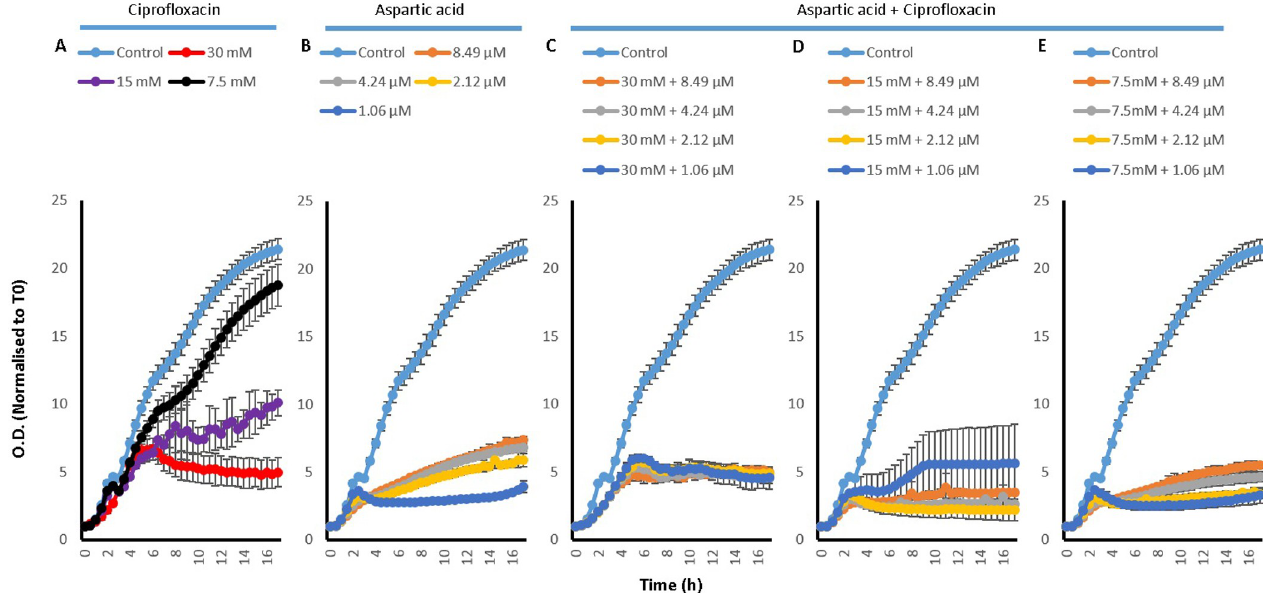
Fig 3. S . aureus growth curves with A) 30, 15 and 7.5 mM L-Asp amino acid on its own, B) with 8.49, 4.24, 2.12 and 1.06 μ M Cip on its own, C) 30 mM L-Asp combined with 8.49, 4.24, 2.12 and 1.06 μ M Cip, D) 15 mM L-Asp combined with 8.49, 4.24, 2.12 and 1.06 μ M Cip and E) 7.5 mM L-Asp combined with 8.49, 4.24, 2.12 and 1.06 μ M Cip; n =